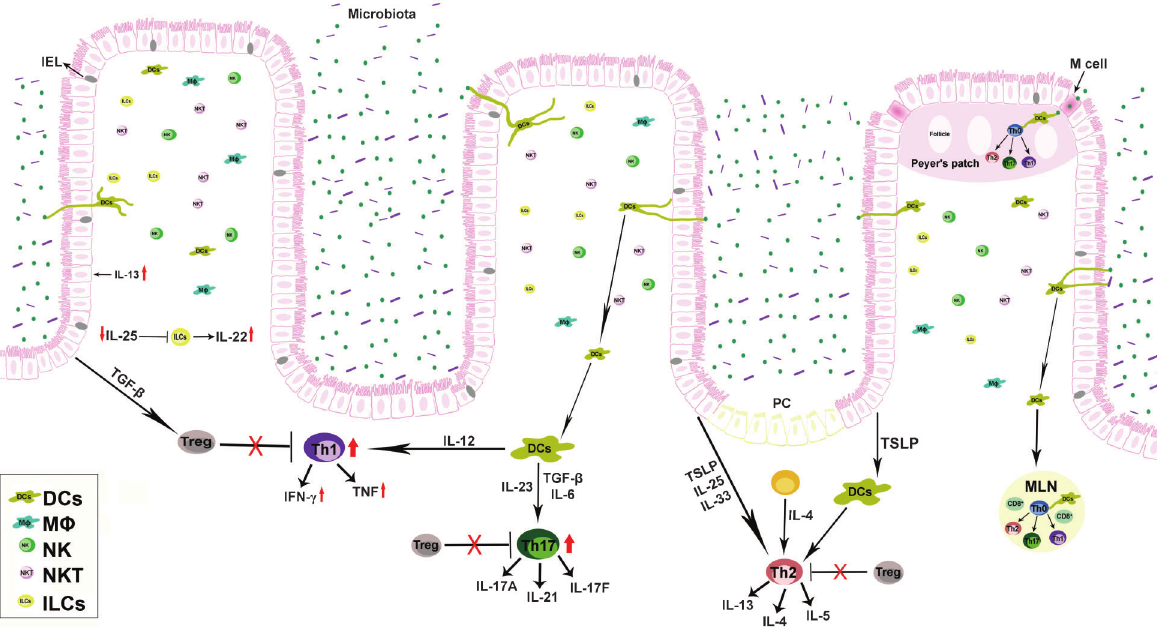
Figure 1. Intestinal immune response in the development of inflammatory bowel disease (IBD). The immune surveillance of the intestine is composed of several cell types, including dendritic cells (DCs), macrophages (M W ), natural killer (NK) cells, natural killer T (NKT) cells, innate lymphoid cells (ILCs) and intraepithelial lymphocytes (IEL). All these components are altered in some way during IBD. The breakdown of immunological tolerance causes recognition of the intestinal microbiota by the local immune system, activating the inflammatory cascade. The physical/chemical barriers composed by IEL, Paneth cells (PC), microfold cells (M cells) or their products are impaired during the disease and fail to restrain bacterial invasion. In lamina propria (LP), DCs capture and recognize bacterial antigens by projecting their dendrites into the intestinal lumen between intestinal epithelial cells (IEC), while in the Peyer’s patches (PP) the antigens become available to DCs through M cells. Afterwards, the LP and PP DCs migrate to the mesenteric lymph nodes (MLN) and present the antigens to naive T cells (Th0). Meanwhile, the PP DCs may also present antigens to Th0 cells located in the follicles. The antigen presentation in the presence of the cytokines interleukin (IL)-12 or IL-23/IL-6/transforming growth factor-beta (TGF- b ) leads to polarization of Th0 cells into a pro-inflammatory Th1 or Th17 profile, respectively, which are increased due to low number or function of regulatory T cells (Treg). Th1 and Th17 cells secrete cytokines such as tumor necrosis factor (TNF), interferon c (IFN- c ), IL17A, IL-17F and IL-21, which in turn contribute to tissue injury and excessive inflammatory response, especially in Crohn’s disease. In addition, cytokines such as IL-4, IL-33, IL-25 and thymic stromal lymphopoietin (TSLP) directly or indirectly contribute to the differentiation of Th0 cells into Th2 profile in ulcerative colitis, which may also be under low control of Tregs. The red arrows indicate components that are altered in IBD. The red crosses indicate the absence or reduced function in IBD. It is noteworthy that cytokines